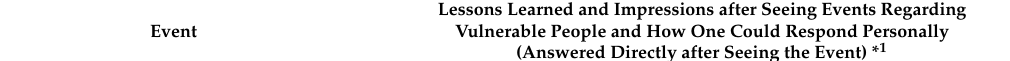
Table 4. Lessons learned and impressions after seeing events regarding vulnerable people and how one could respond personally (n =